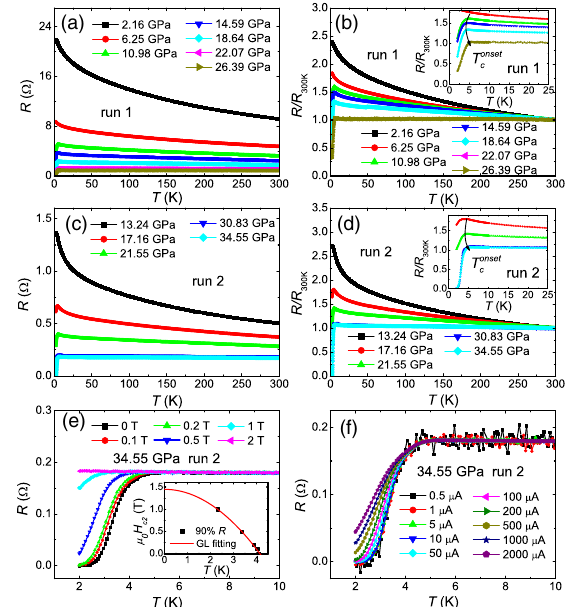
FIG. 4. Pressure-induced superconductivity in CsFe 4 − x Se 4 . (a,b) Temperature-dependent resistance and normalized resis- tance at high pressures for run 1. The inset in panel (b) shows an enlarged view on the normalized data in the low-temperature region (0 – 25 K). (c,d) Temperature-dependent resistance and normalized resistance at high pressures for run 2. The inset in panel (d) shows an enlarged view of the same data in the low- temperature region (0 – 25 K). (e) Superconducting transition curves measured under different magnetic fields at 34.55 GPa of run 2. The inset in panel (e) shows the phase diagram of the upper critical field. (f) Superconductivity measured with different electric currents at 34.55 GPa of run